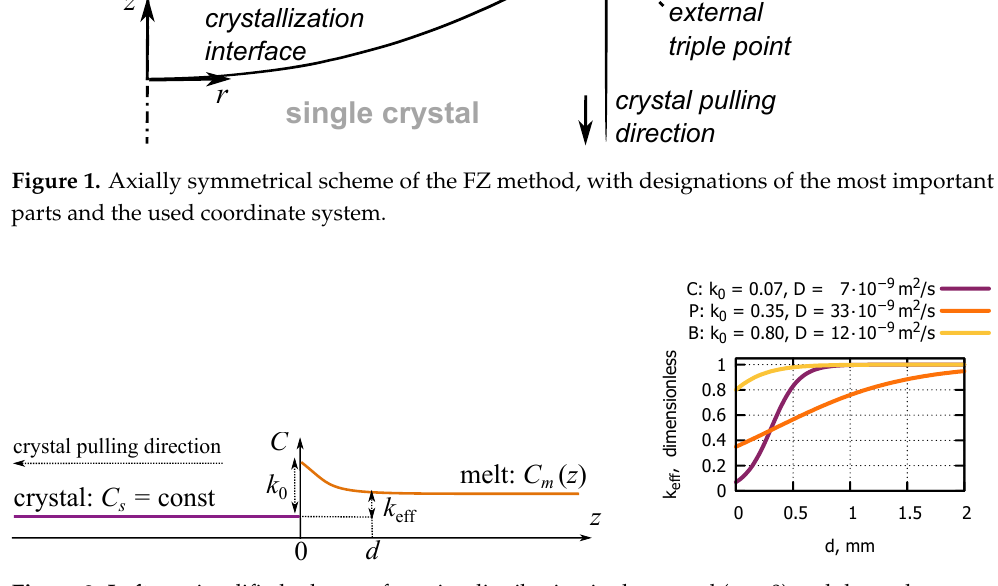
Figure 2. Left —a simplified scheme of species distribution in the crystal ( z < 0) and the molten zone ( z > 0) near the interface ( z = 0). Right —the dependence of the effective segregation coefficient k eff on diffusion layer thickness d (e.g., [4]) for different